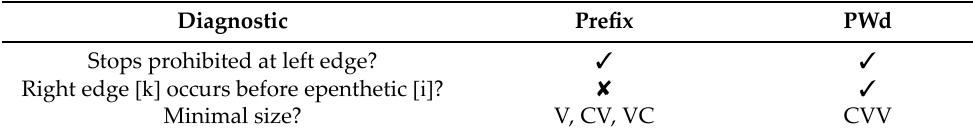
Table 8. Comparison of prefixes and PWd